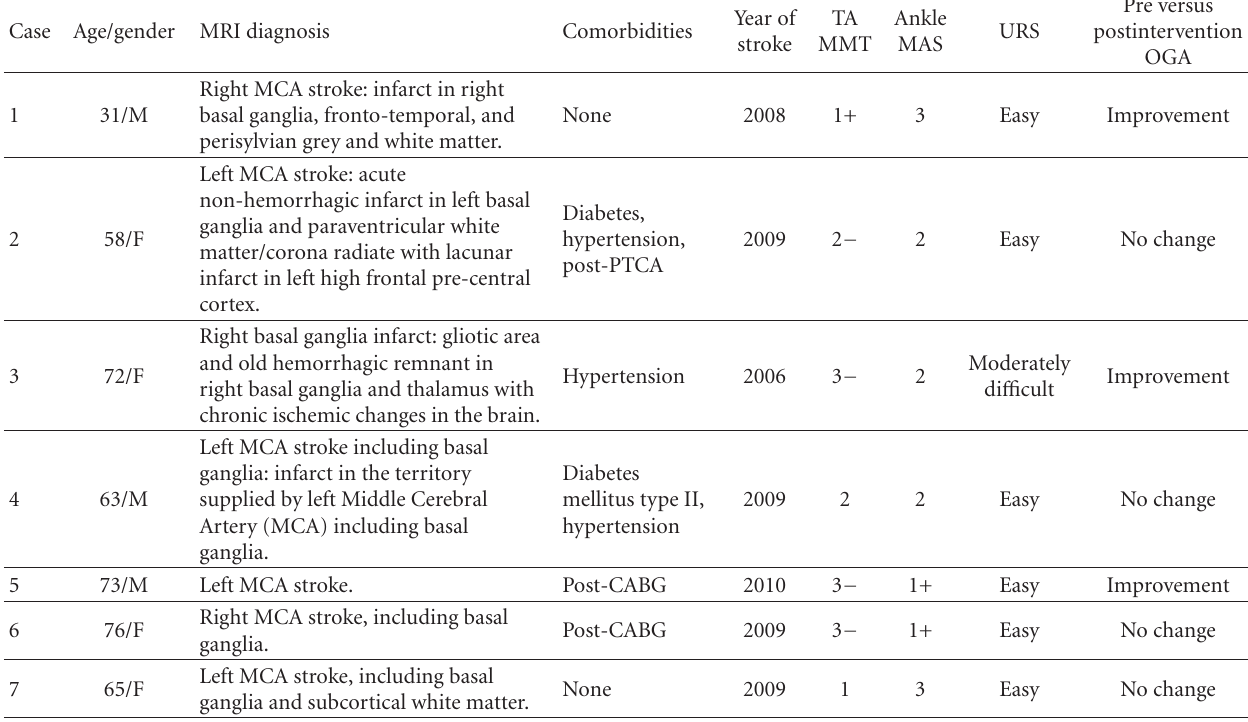
Table 2: Summary of the case series (M: male, F: female, MCA: middle cerebral artery, PTCA: percutaneous transluminal coronary angi- oplasty, CABG: coronary artery bypass graft, TA: tibialis anterior muscle, MMT: manual muscle test, MAS: modified Ashworth scale, URS: usability rating scale, OGA: observational gait analysis, MRI: magnetic resonance